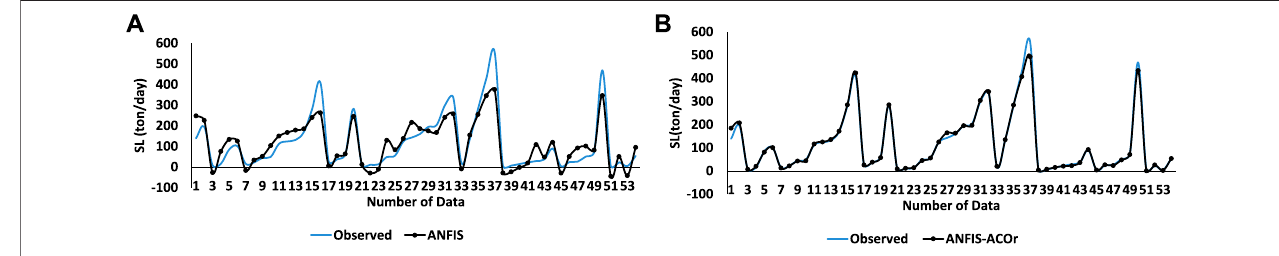
FIGURE 6 | Results for ANFIS and ANFIS – ACOr in the input of Q + CM. (A) Comparing the SL observed with the SL predicted in ANFIS in the test mode, (B) Comparing the SL observed with the SL predicted in the ANFIS – ACOr in test mode.